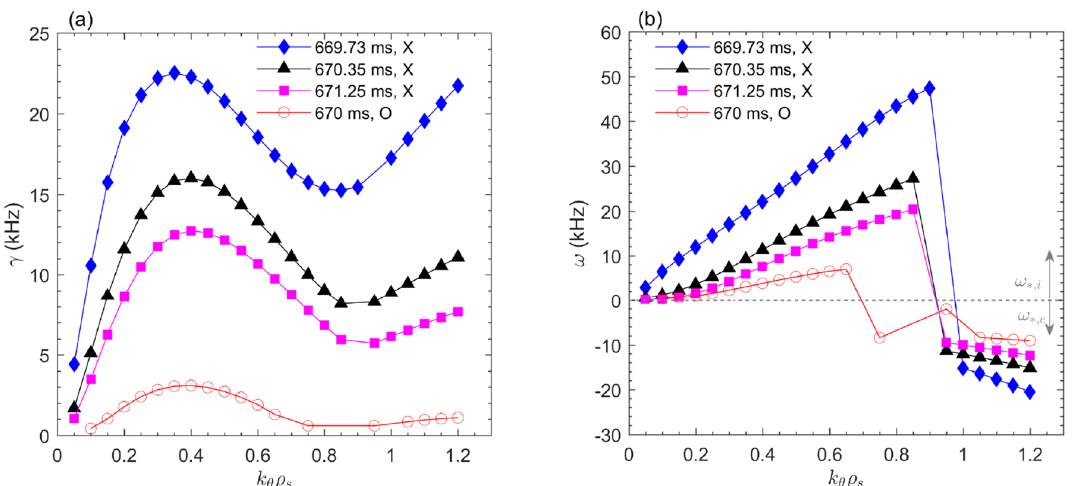
Figure 12. ( a ) Linear growth rates and ( b ) frequencies of the fastest growing micro-instability at R ≈ 185 cm during X-point (669.73 ms, 670.35 ms and 671.25 ms) and O-point (670 ms) phases. ω ∗ , i and ω ∗ , e in ( b ) denote the ion and electron diamagnetic drift direction, respectively